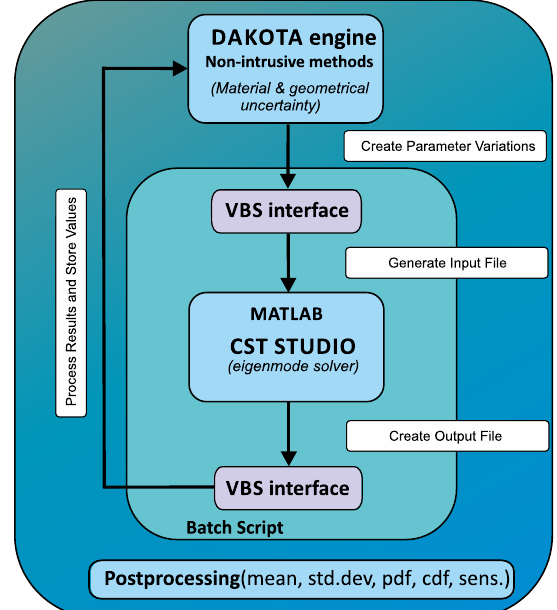
FIG. 5. Result of the global sensitivity analysis for f